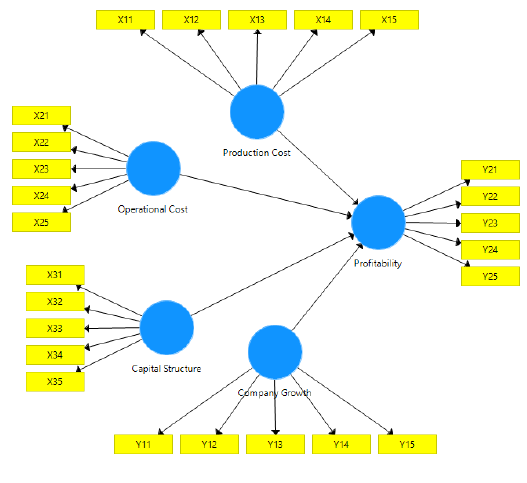
Fig. 1. Research Model